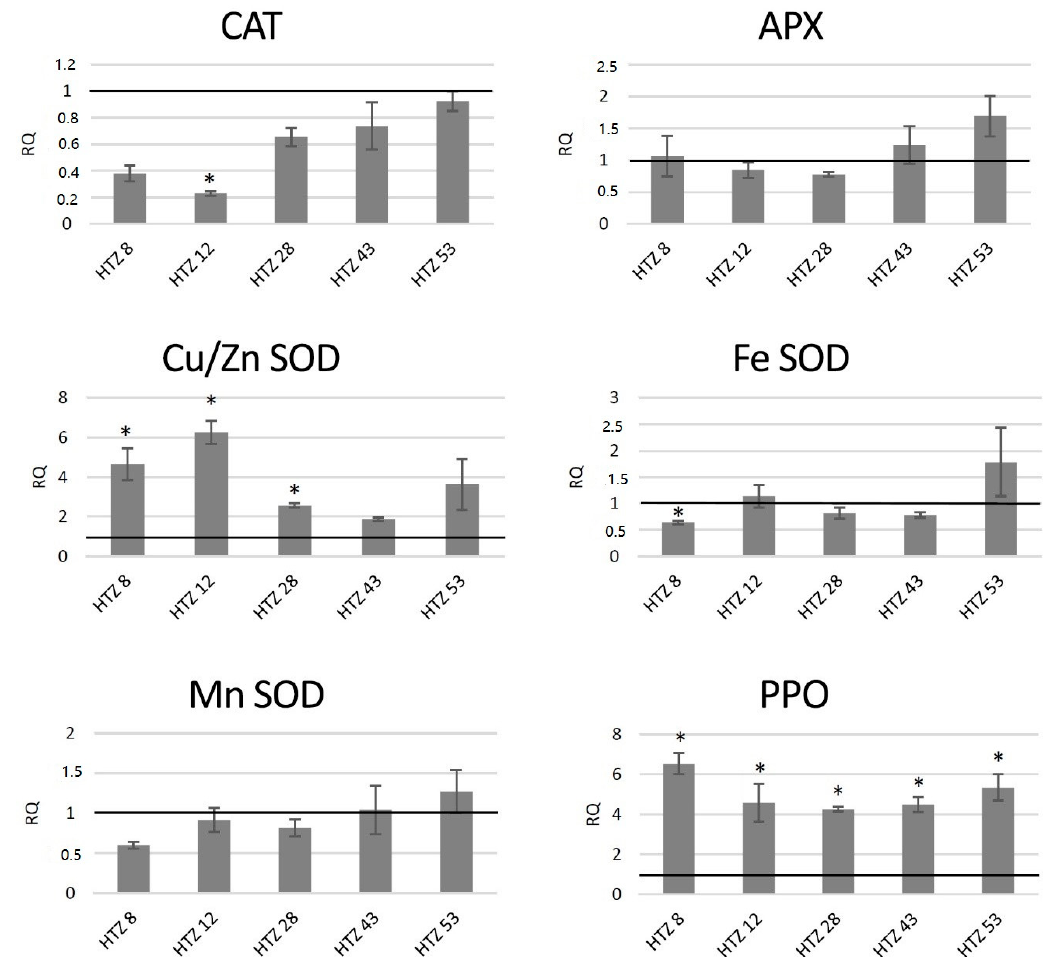
Figure 7. The level of transcript of genes involved in free radical processing ( CAT —catalase, APX —ascorbate peroxidase, SOD —superoxide dismutase, and PPO —polyphenol oxidase) in the HTZ lines presented as relative quantification (RQ) in relation to the non-transgenic control (horizontal line at RQ = 1). The elongation factor gene was used as a reference gene. The results were obtained with the RT-qPCR method on the cDNA matrix as the mean values of three biological repeats ± standard deviation. Statistically significant changes ( p < 0.05) are marked with asterisks.